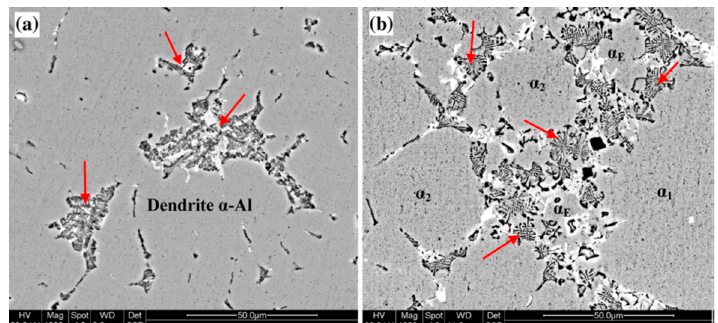
Figure 6. SEM images showing the morphology of Mg 2 Si phase in ( a ) conventional SC and ( b ) rheo-SC 5052 Al parts [83].